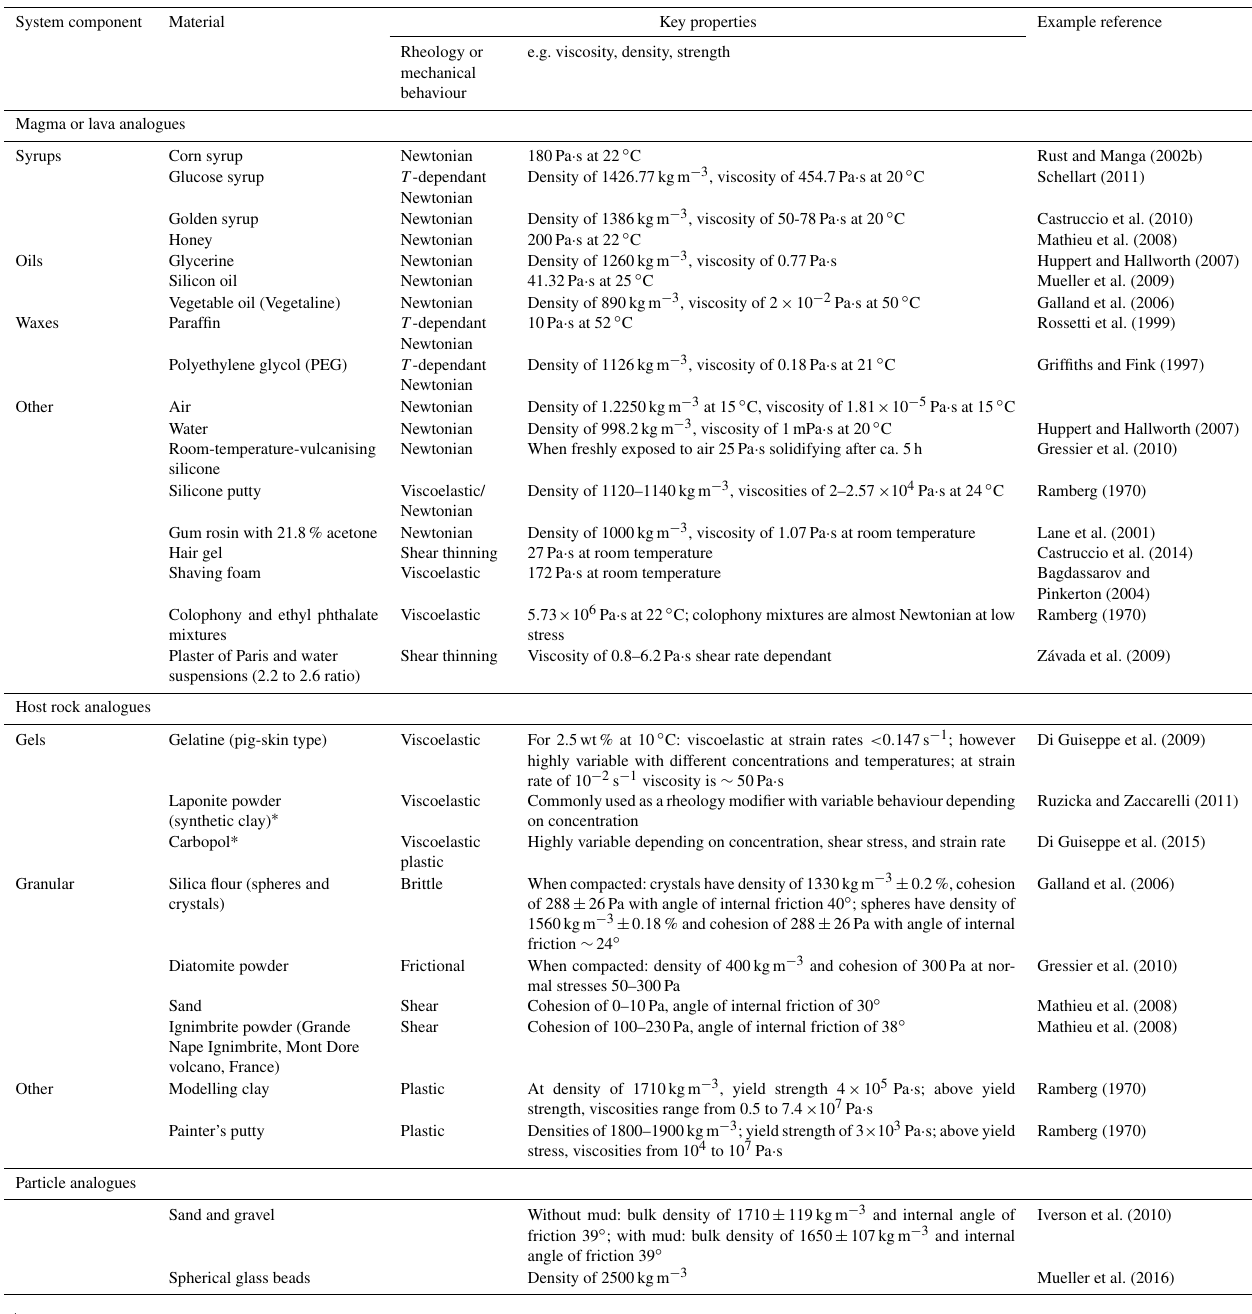
Table 1. Properties of analogue materials used to model magmas and lavas for rheology and